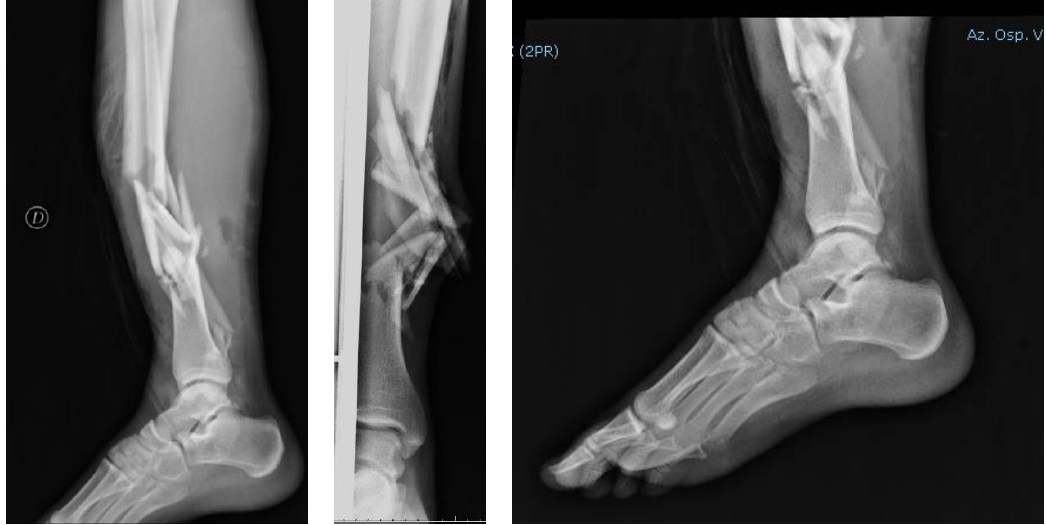
Figure 2 . Pre-surgical emergency radiographs; anteroposterior (AP) and left lateral (LL) projections of the right leg and ankle.